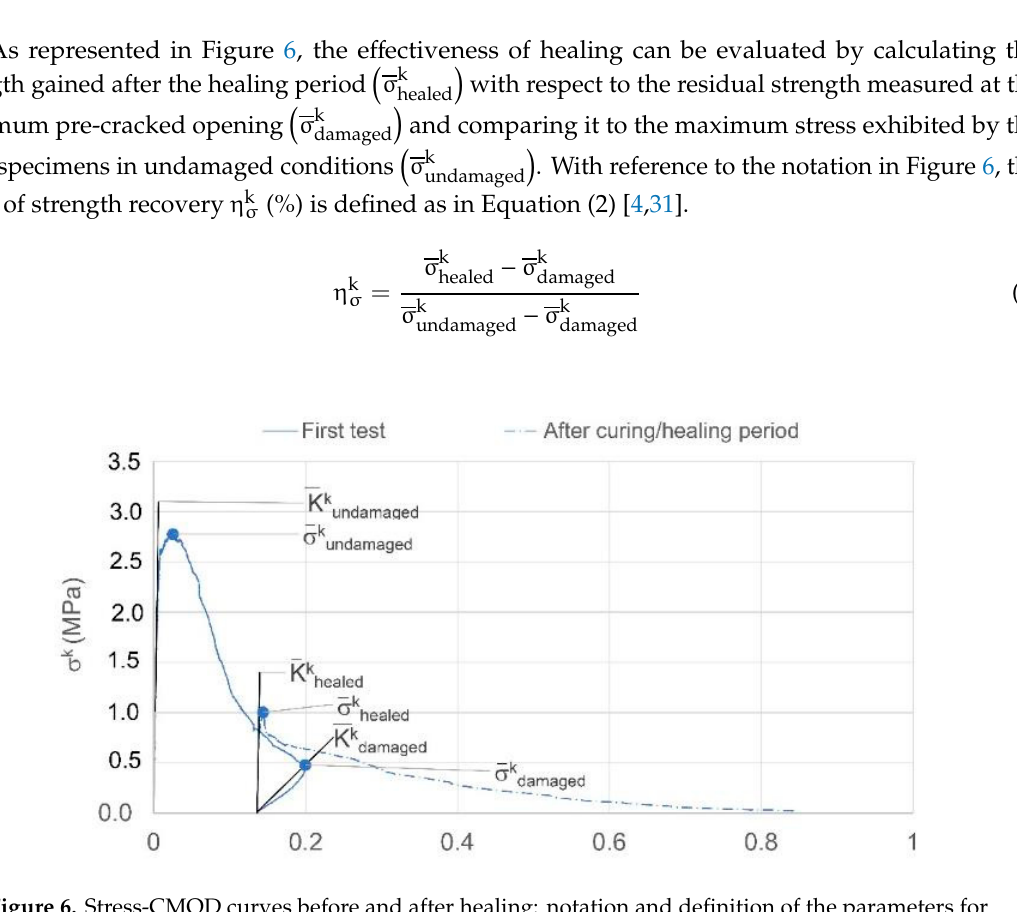
Figure 6. Stress-CMOD curves before and after healing: notation and definition of the parameters for the indices of healing.